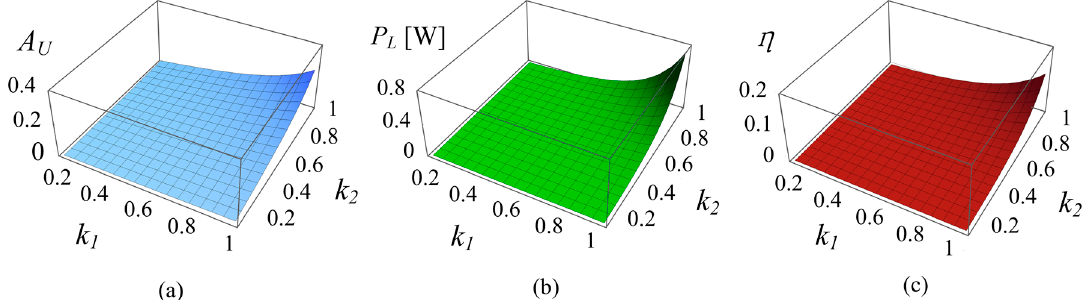
Figure 8. ( a ) Surface diagram of voltage gain related to coupling factor; ( b ) Surface diagram of power related to coupling factor; ( c ) Surface diagram of efficiency to coupling factor. ( A U : voltage gain; P L